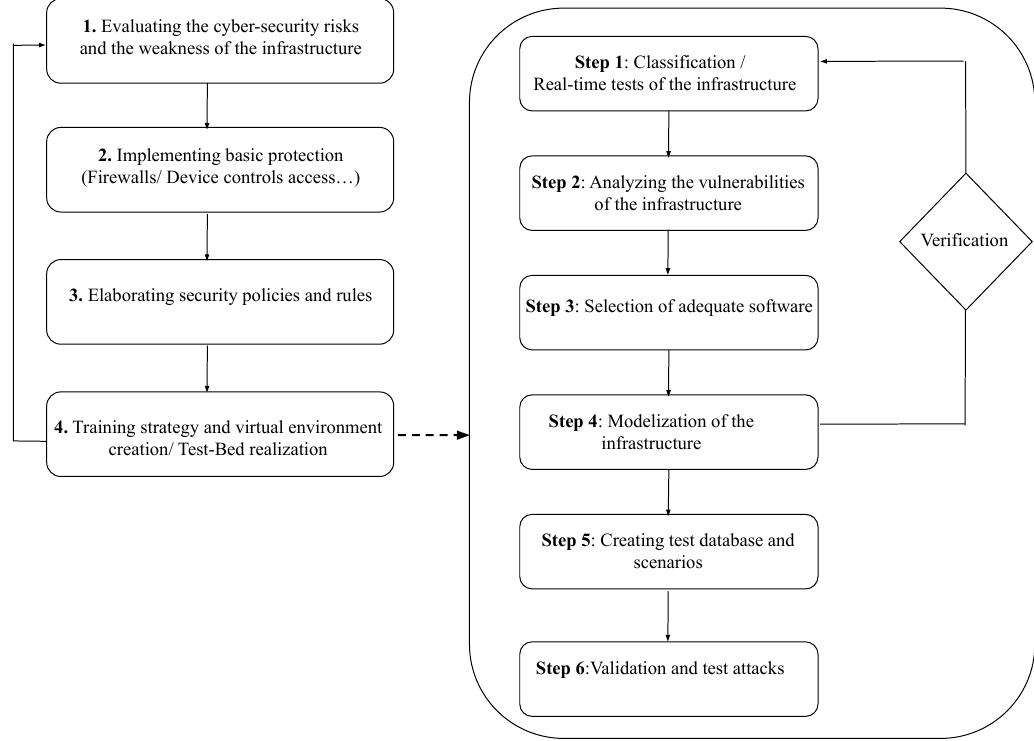
Figure 16. Cyber-Range/Test-Bed